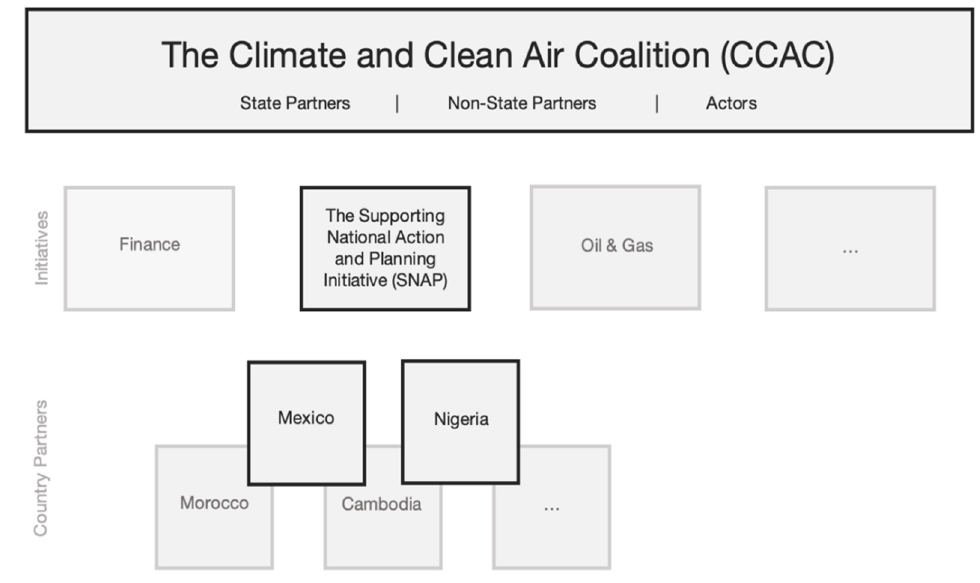
Figure 1. The structure of the Climate and Clean Air Coalition (CCAC). Source: the authors.